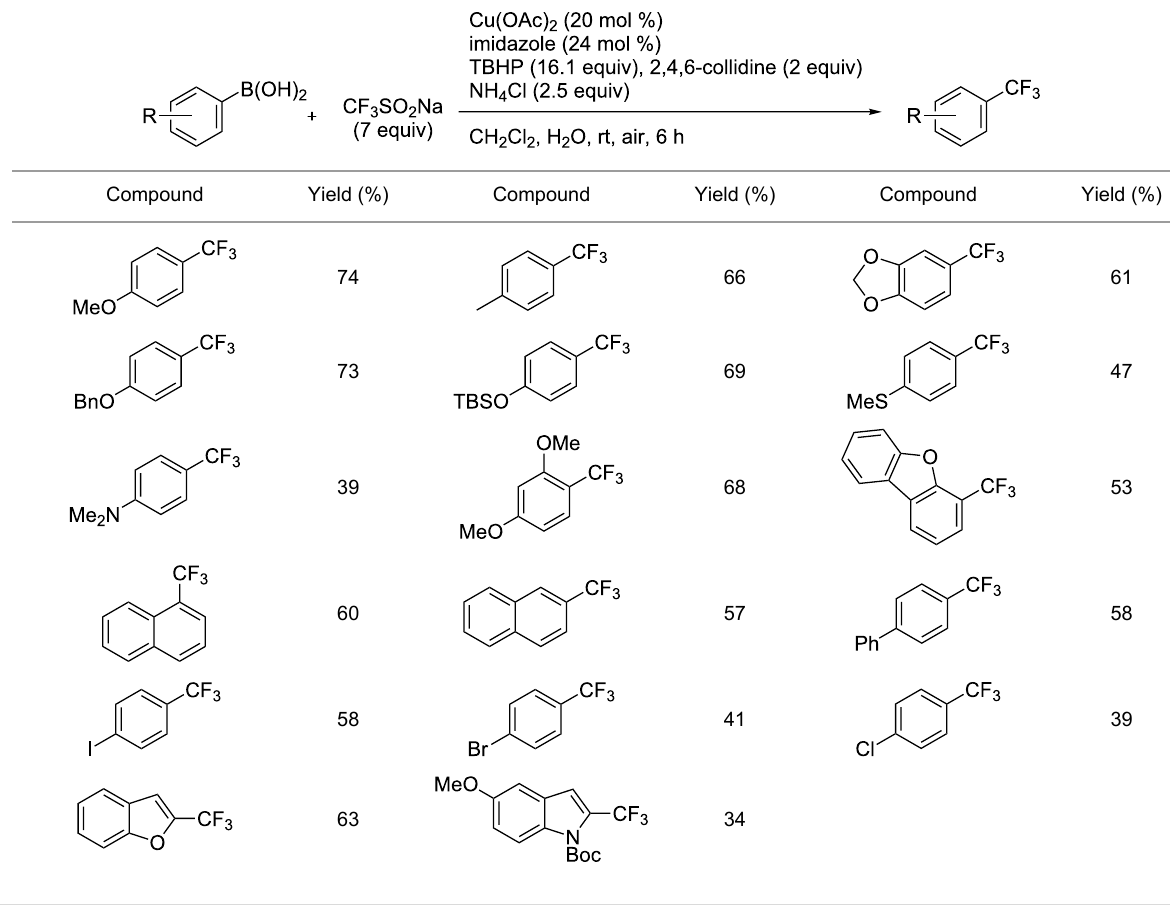
Table 27: Cu-catalyzed trifluoromethylation of (hetero)arylboronic acids [97].